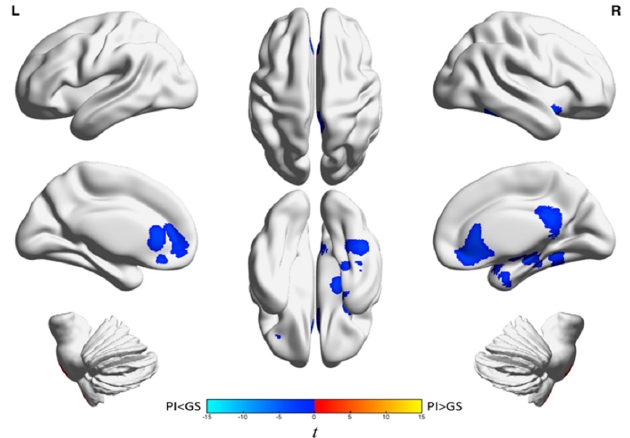
Figure 2. Group differences in relative glucose metabolism during non-rapid eye movement (NREM) sleep. We assessed relative regional cerebral metabolic rate for glucose (rCMR glc ) in a sample of 44 patients with primary insomnia (PI) and 40 good sleeper controls (GS) during NREM sleep. Patients with PI had lower relative rCMR glc in three clusters centered on the anterior cingulate, right medial temporal lobe, and right precuneus/posterior cingulate; p 3DC_corrected <0.05 for all clusters. A full list of brain regions involving these clusters is presented in Table 1. The color bar represents t values; blue indicates regions where PI had lower relative rCMR glc than GS during NREM sleep. This figure was originally published in the journal Sleep in 2016 [52]. Used with permission. Note: L indicates the left side of the brain, R indicates the right side of the brain, and 3DC_corrected indicates that familywise error (FWE) correction and clusterwise extent thresholds were determined using 3dClustSim [53].